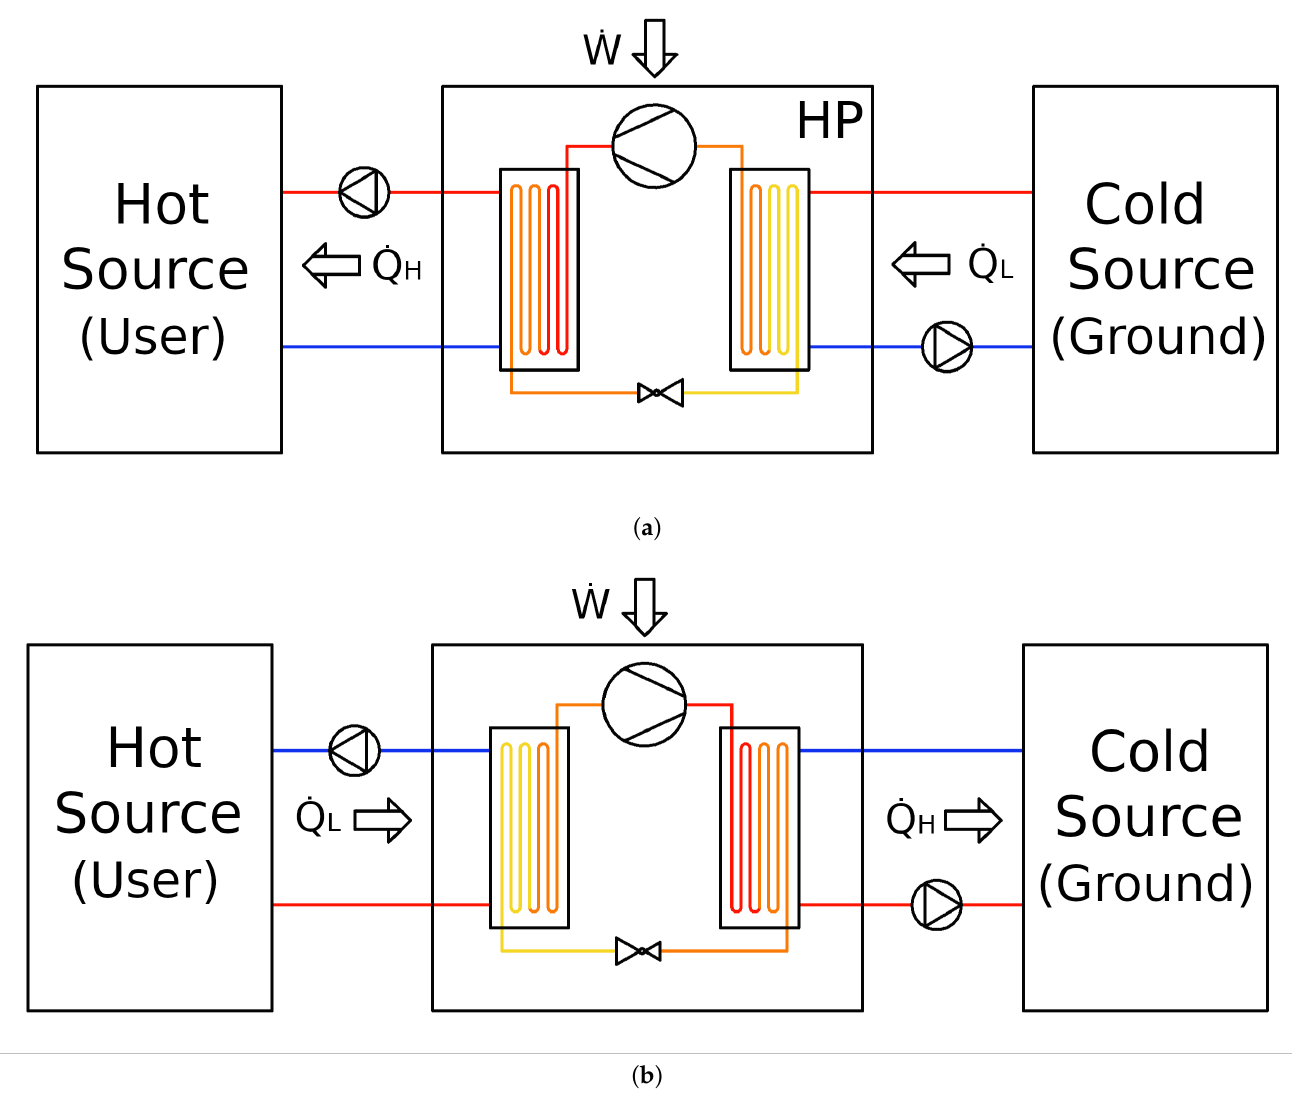
Figure 2. Ground-source heat pump working cycles in heating ( a ) and cooling ( b )